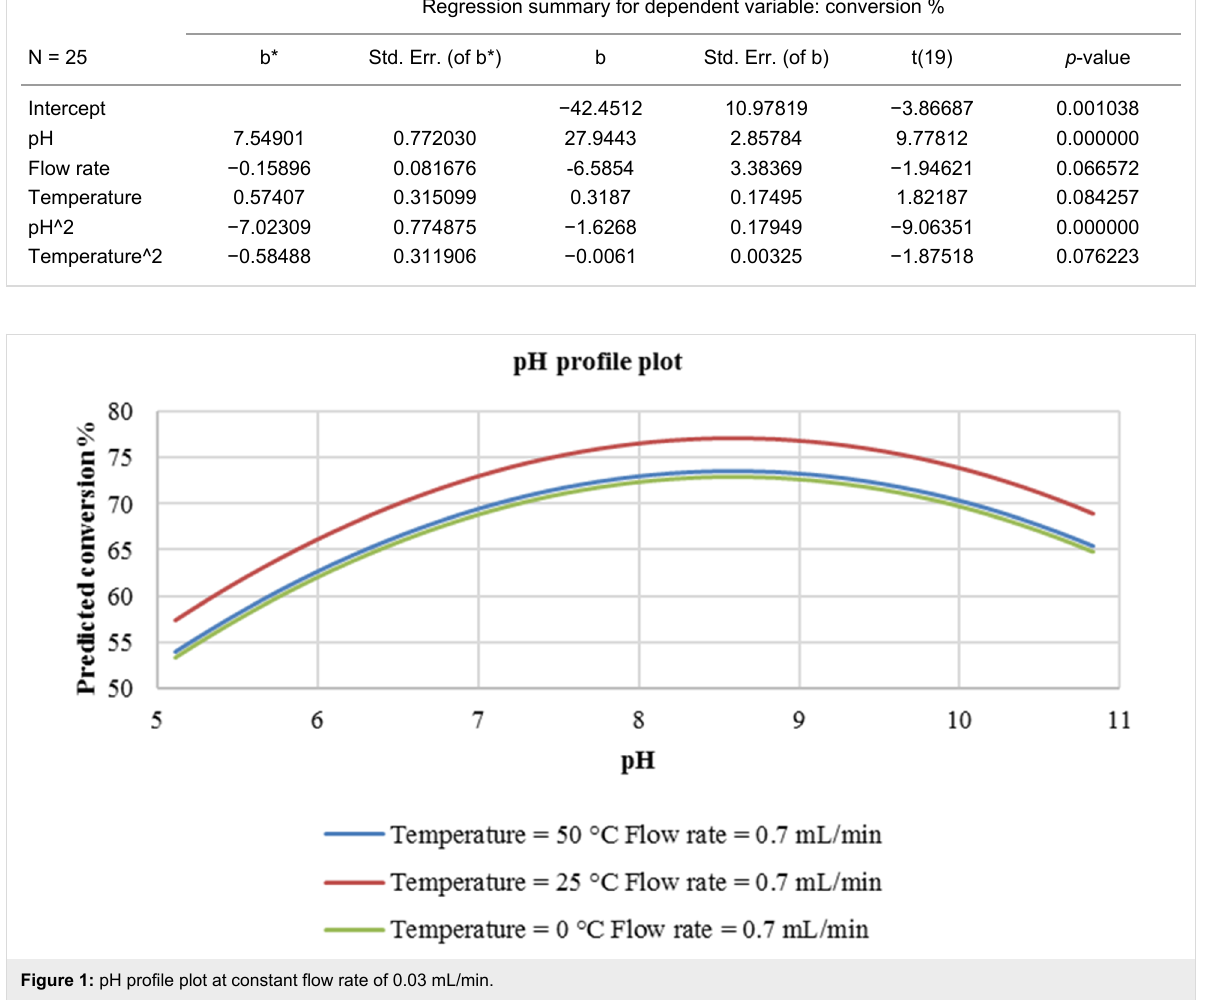
Table 2: Statistical multiple regression analysis output.